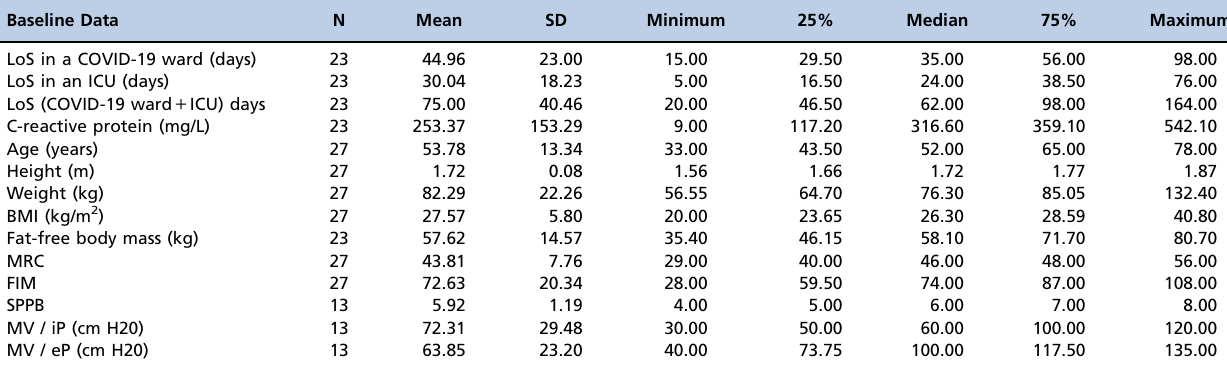
Table 1 - Continuous variables of the baseline demographics and characteristics of the patient population at admission for inpatient rehabilitation. Baseline